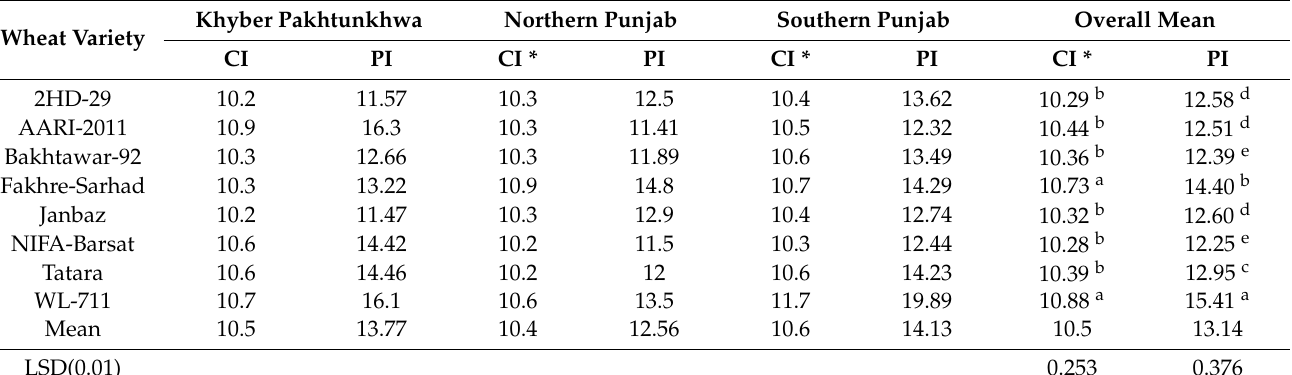
Table 4. Aggressiveness analysis of T. indica isolates on wheat varieties based on coefficient of infection and percent infection, as expressed against isolates from various wheat growing